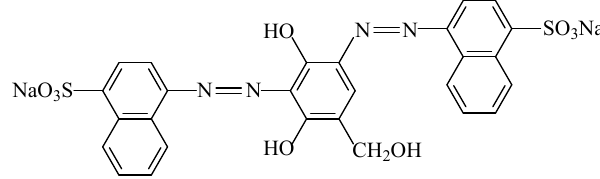
Figure 28. Structural formula of brown HT (E155).